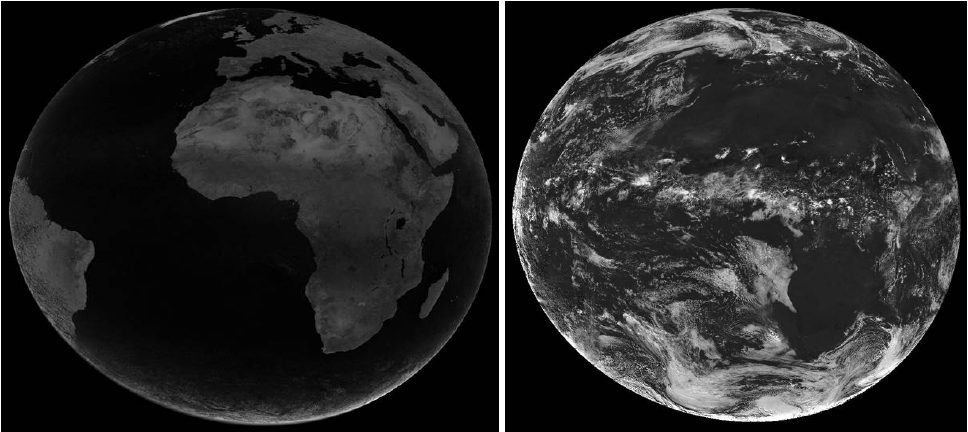
Figure 2. Example of the clear sky reflection ρ cs (left) and effective cloud albedo CAL (right) for an 11 UTC slot in June